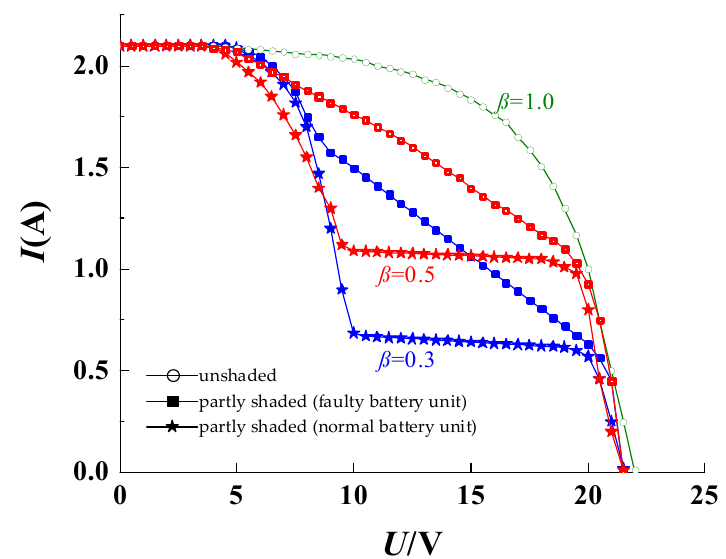
Figure 12. Normal/faulty PV module output I-U characteristic data under different β .